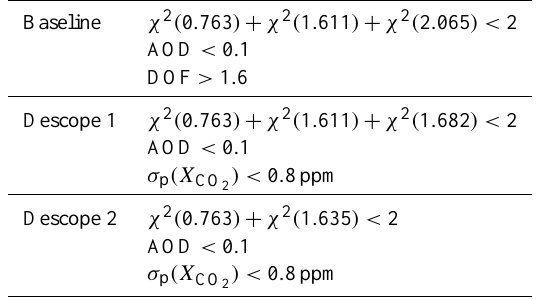
Table 5. Post-processing filters used in the experiments; χ 2 (λ) de- notes the residual χ 2 for the band with central wavelength λ , AOD denotes the retrieved aerosol optical depth at the blue end of the O 2 A-band, DOF is the number of degrees of freedom for signal in the retrieved profile of CO 2 , and σ p (X) denotes the posterior estimate of the error in X .